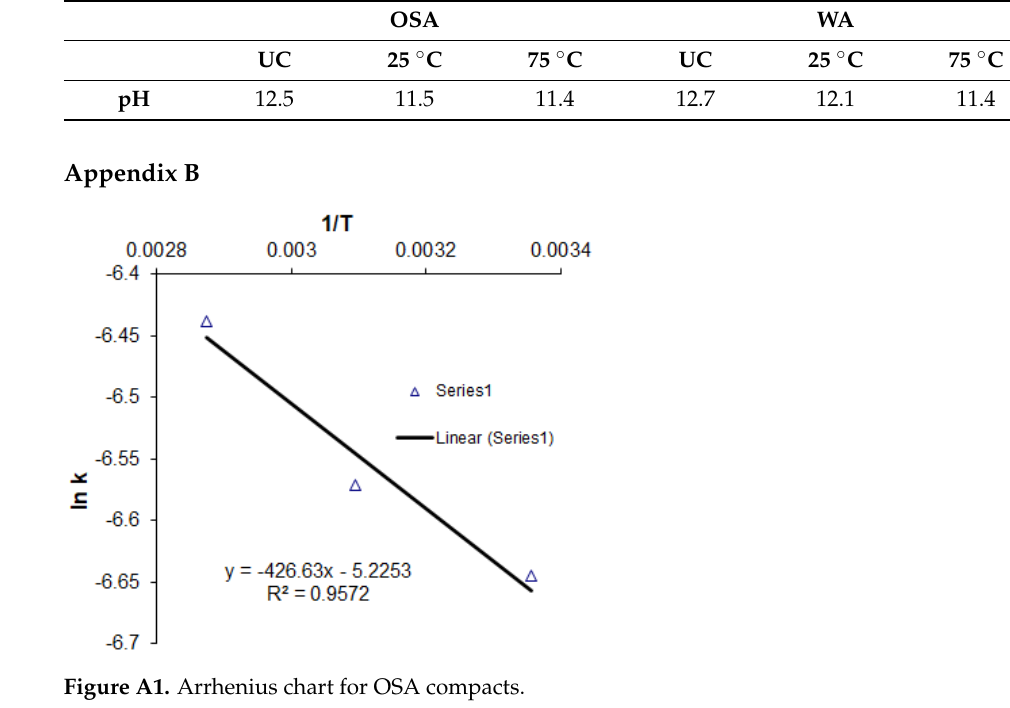
min −1 Figure A2. Arrhenius chart for WA compacts. Table A3. * Reaction parameters for WA compacts. T, K